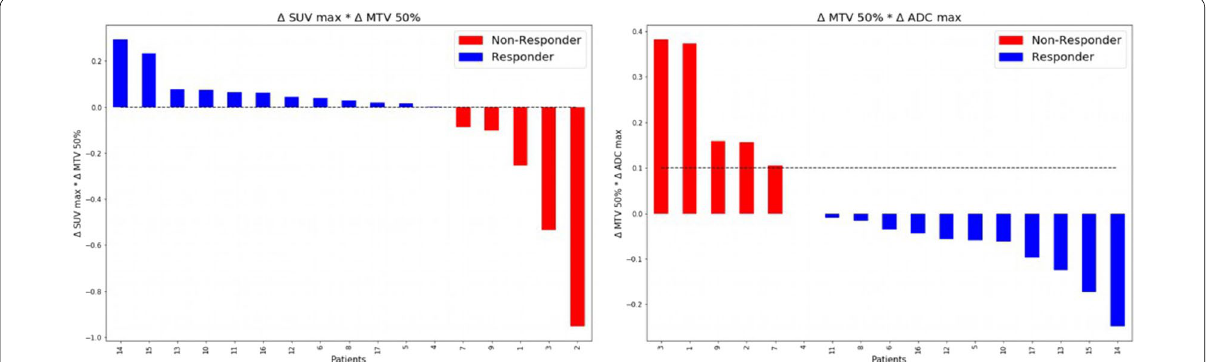
Fig. 3 Combining ∆SUV max and ∆MTV 50% as well as and ∆MTV 50% and ∆ADC max enables perfect differentiation between chemotherapy responders versus